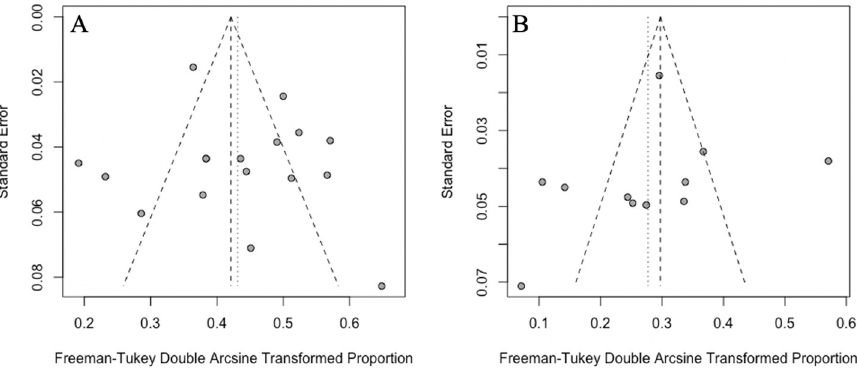
Fig 5. Funnel plots assessing publication bias. A: Funnel plot assessing publication bias in studies reporting the prevalence of PE in AE-COPD patients; B: Funnel plot assessing publication bias in studies reporting the prevalence of DVT in AE-COPD